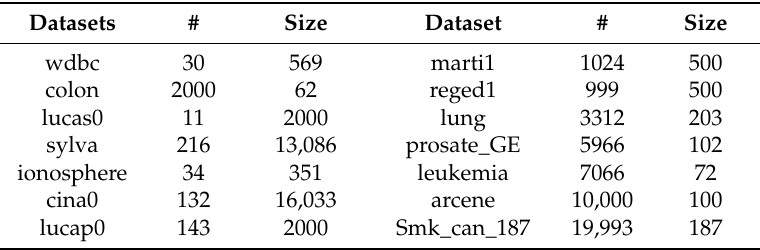
Table 3. Summary of the benchmark datasets.